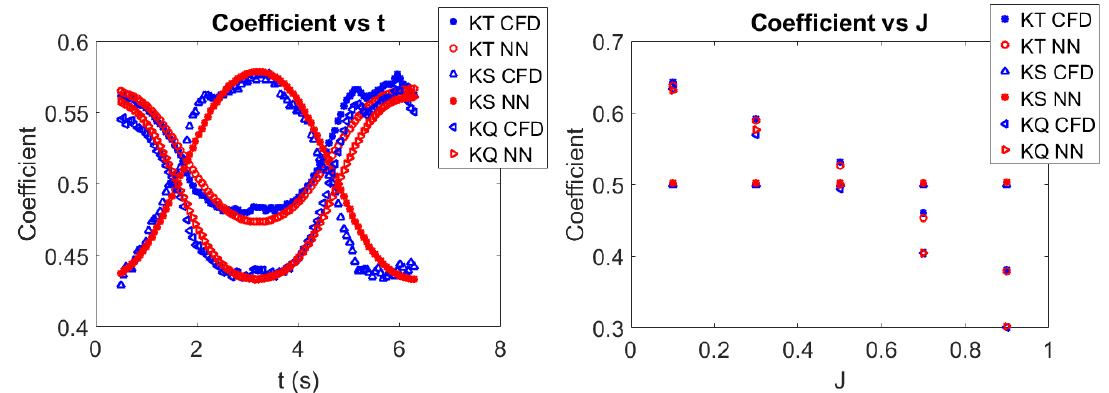
Figure 13. Coefficients for the behind condition training cases. Left: Unsteady training. Right: Steady